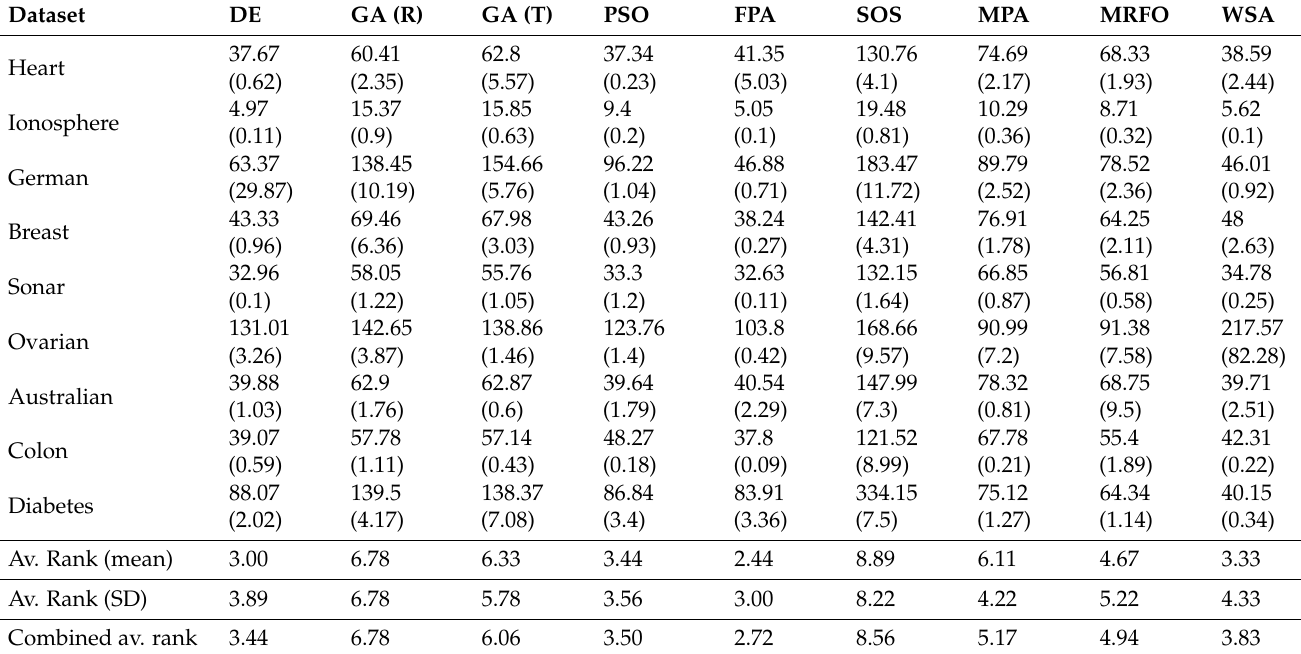
Table 8. Mean (and standard deviation) of computational time achieved by each algorithm for each dataset in repeated trials.